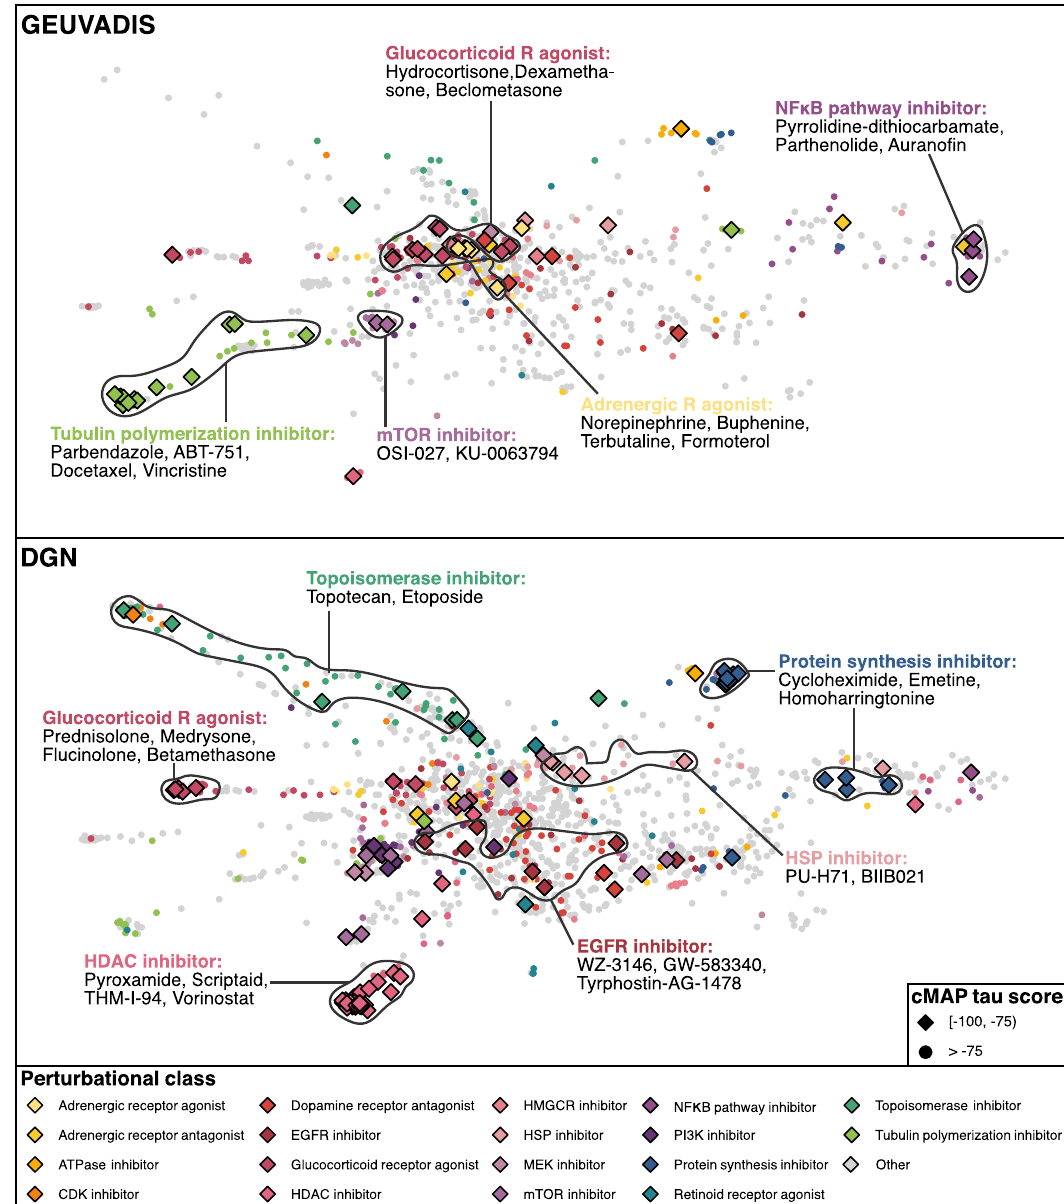
Fig.4|ComputationaldrugrepurposinganalysisviaConnectivityMap(CMap). We used signi fi cant SLE TWAS associations ( P value <2.5×10 − 6 ; two-sided P value associated with each gene iscalculated based on the TWASZ scorefor gene-based association test) in CMap to identify drugs that could potentially reverse the dis- ease signature. Data are visualized with L1000FWD. Each point represents cell- speci fi c drug-induced signature, and signatures were clustered via k-nearest neighbors. To quantify the correlation between a query signature and reference pro fi le,CMapcalculates a τ score. A negative τ scoreindicates